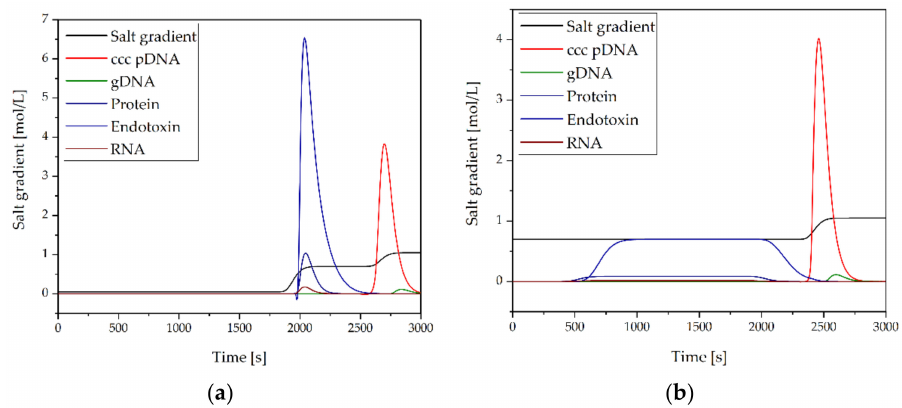
Figure 11. Comparison of the scaled-up process ( a ) and the optimized process ( b ).